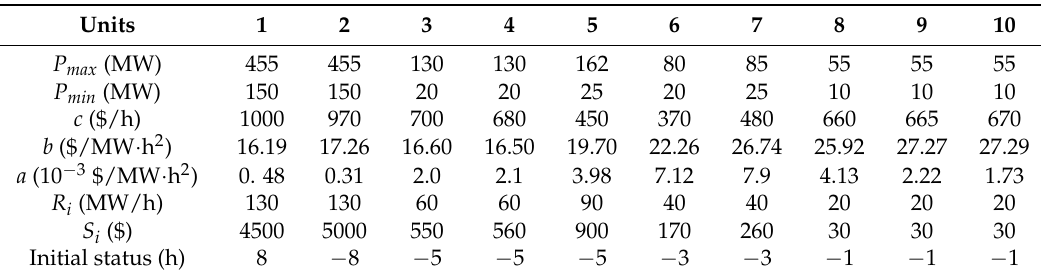
Table 2. Parameters of 10 units